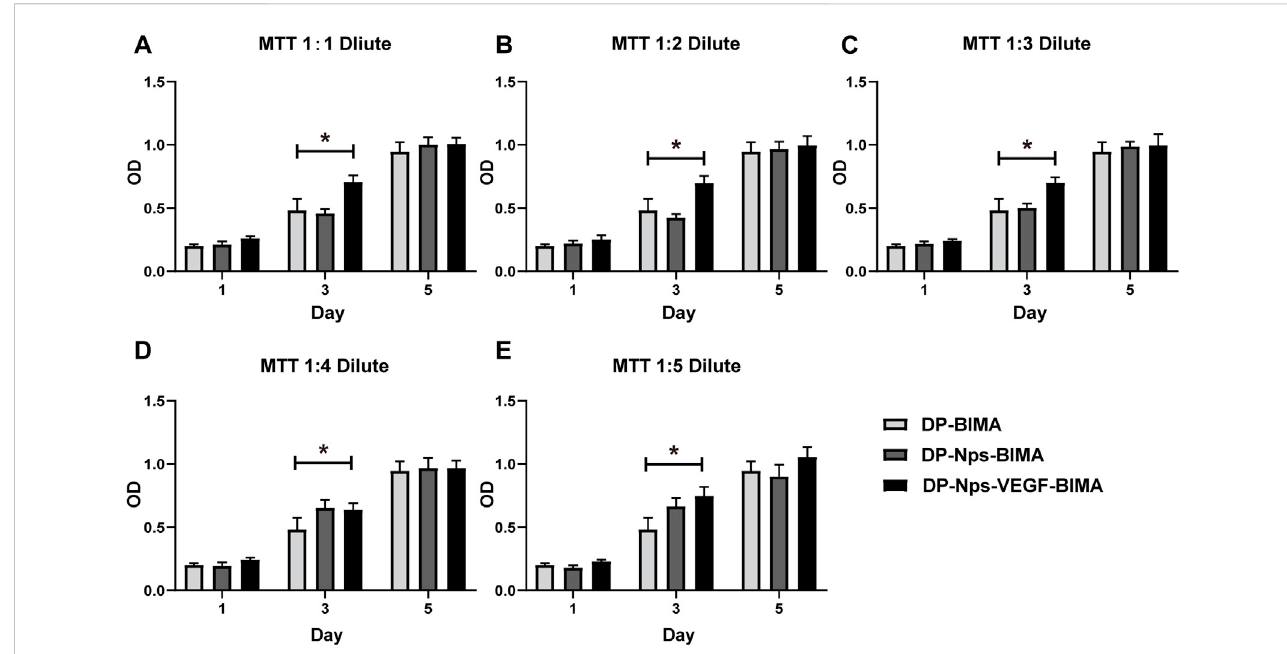
FIGURE 5 The results of MTT assay with 1:1 diluent (A) , 1:2 diluent (B) , 1:3 diluent (C) , 1:4 diluent (D) , and 1:5 diluent (E) , n = 3. * indicated statistical difference ( p < .05).